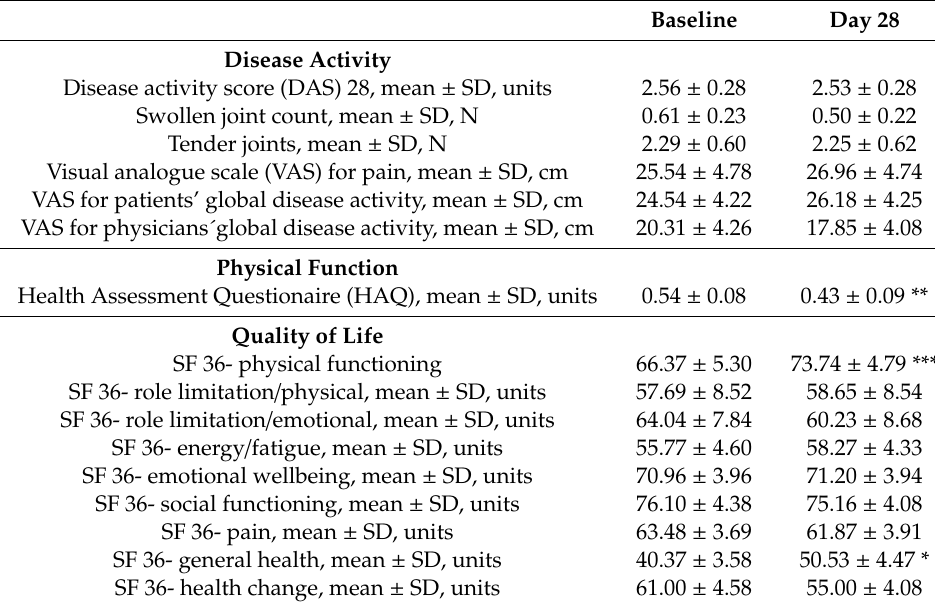
Table 2. Clinical assessment of participating patients.